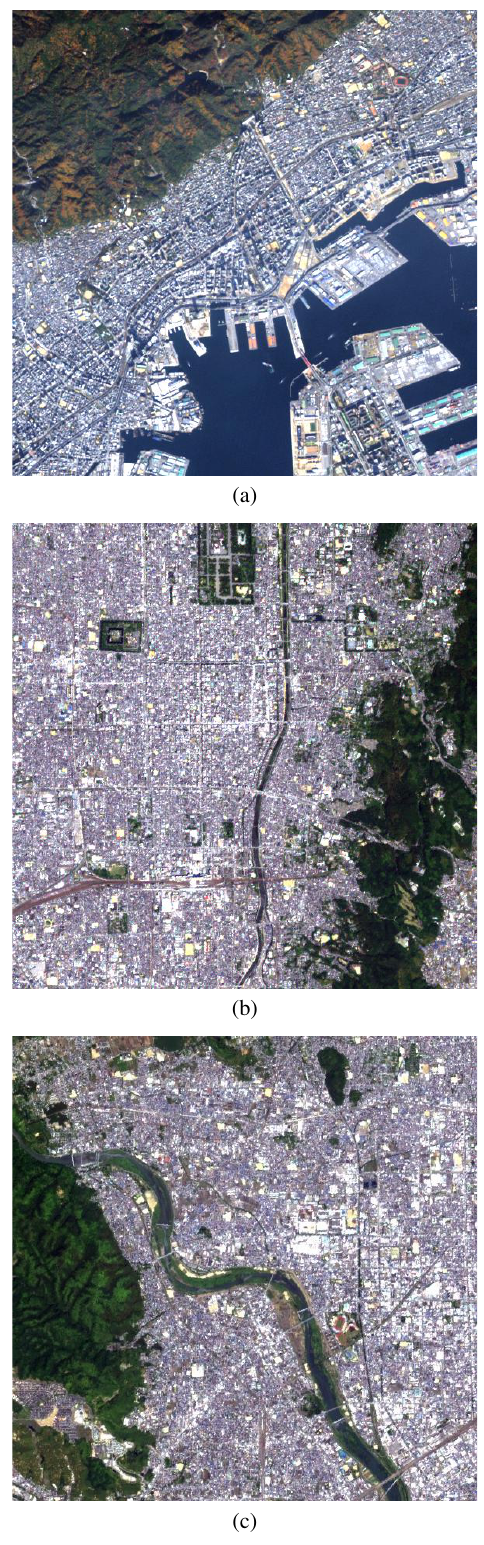
Figure 1. ALOS/AVNIR-2 images of (a) study area 1, (b) study area 2 and (c) study area 3 (R:G:B=Band3:2:1). The image